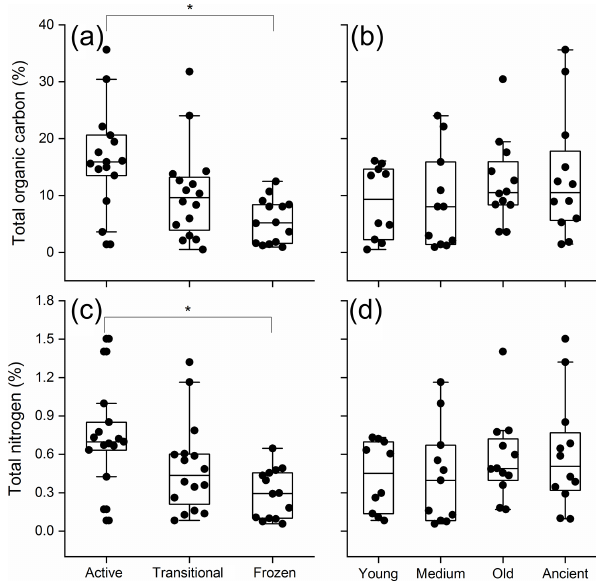
Figure 1. Total organic carbon ( a and b ) and total nitrogen ( c and d ) with the permafrost age (young, medium-aged, old, and ancient) and permafrost thawing status (active, transitional, and permanently frozen).